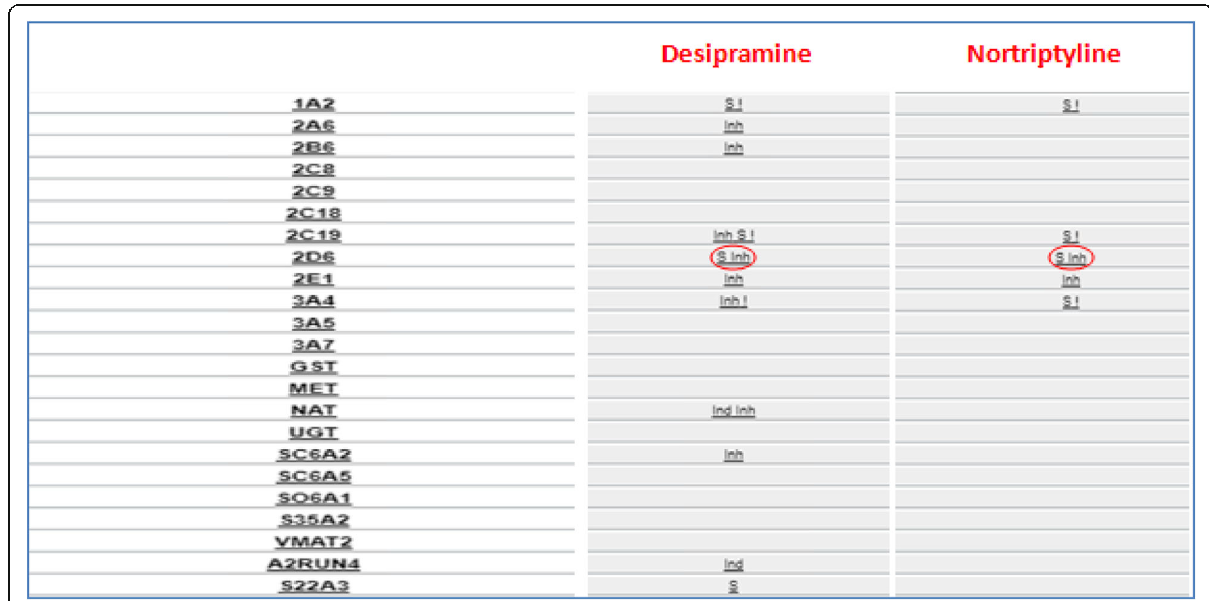
Fig. 8 Secondary amines metabolic profile. From left to right, in the first column there is the list of drug metabolizing enzymes, one for each row; in the second and third columns relationship between corresponding enzyme of the row and different Tricyclic: is indicated by the symbol ‘ S ’ for substrate, ‘ Inh ’ for inhibitor and ‘ Ind ’ for inducer. Enzyme 2D6 is rimmed to emphasize their importance in these secondary amines ’ metabolic